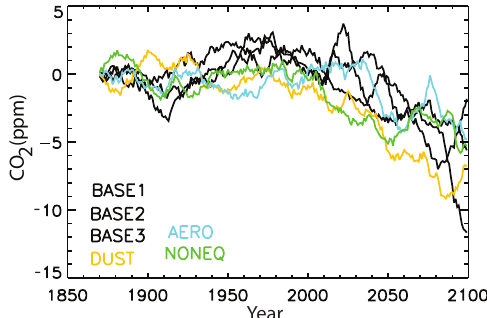
Fig. 2. Globally averaged change in CO 2 (ppm) from including climate impacts from CO 2 in the coupled-carbon-climate model for each case in Table 1 for 1870–2100. This is calculated using the case where CO 2 is fully interactive minus the case where CO 2 is set to 287ppm for radiation, e.g. no climate change from CO 2 directly (CASE minus